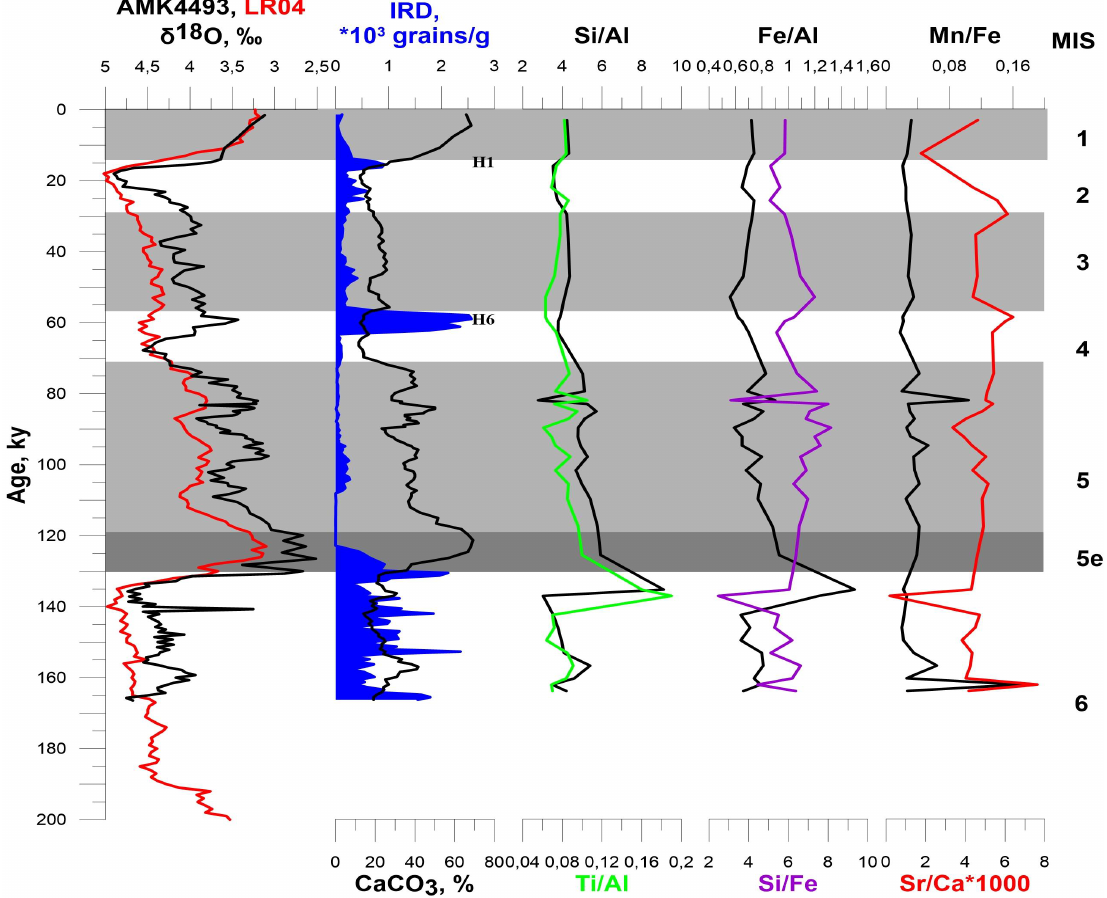
Figure 4. Stable oxygen isotope ratios (‰) in planktonic foraminiferal tests; LR 04_ ‐ standard curve [38]; ice ‐ rafted debris (IRD, (grains/g); CaCO 3 (%); and elemental ratios Si/Al, Ti/Al, Fe/Al, Si/Fe, Mn/Fe, and (Sr/Ca)1000 in AMK ‐ 4493 sediment core (the Gloria Drift). Colored fill indicates the interglacial stages. H1 and H6 are the Heinrich events.